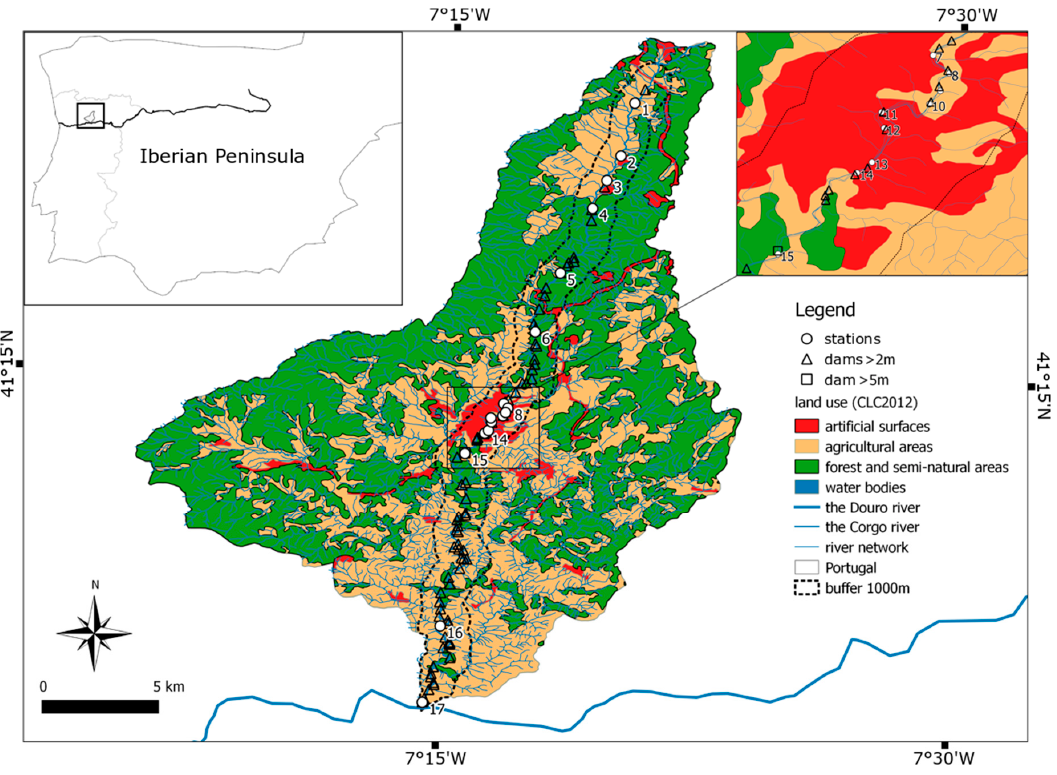
Figure 1. Study area.